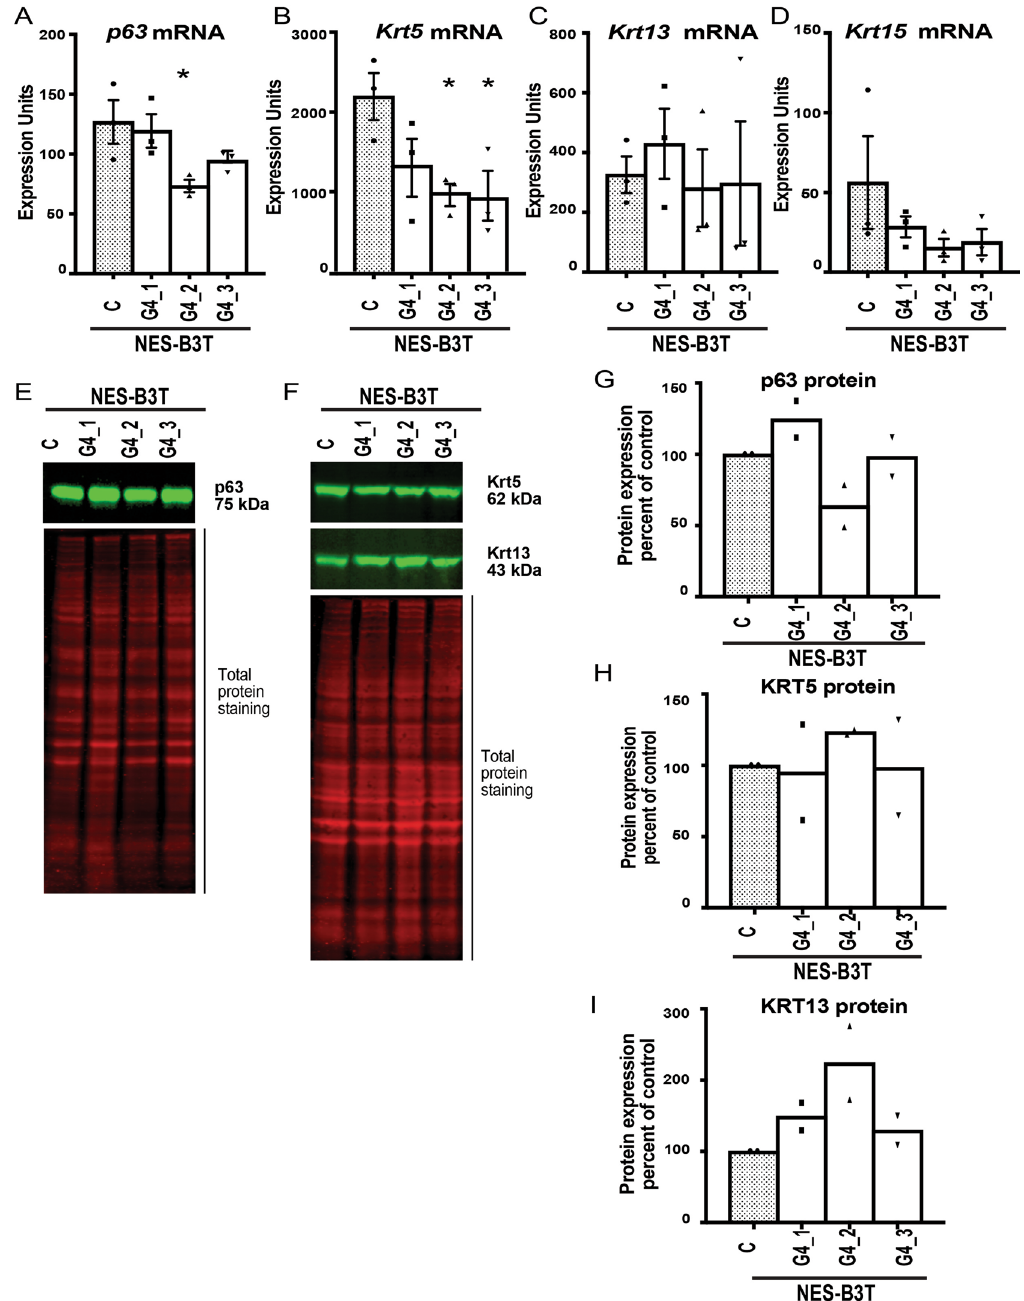
Figure 3. Effects of ectopic expression of GATA4 on the expression of squamous epithelial cell marker genes in human squamous esophageal epithelial NES-B3T cells were less pronounced than those observed in GATA4- expressing NES-B10T cells. Expression of four squamous epithelial cell marker genes (p63, KRT5, KRT13, KRT15 ) were examined by qRT-PCR and/or immunoblot in three pInducer20-GATA4 NES-B3T cell clones (G4_1, G4_2, G4_3) and one pInducer20 NES-B3T control cell clone (C) after 72 h of doxycycline treatment to induce GATA4. ( A – D ) qRT-PCR demonstrated a trend for reduction in the steady-state levels of p63 , KRT5 , and KRT15 , but not KRT13 , in NES-B3T cells expressing GATA4 compared with controls cells lacking GATA4 protein. Statistically significant reductions were observed for only one cell clone, G4_2, for p63 expression and two clones, G4_2 and G4_3, for KRT5 expression (n = 3 experiments; *P ≤ 0.05). ( E – I ) Quantitative infrared immunoblotting (LI-COR) was used to analyze p63, KRT5, and KRT13 protein expression in control and GATA4 expressing NES-B3T cell clones. Revert Total Protein Stain was used for normalization. Immunoblots were performed using extracts from two independent doxycycline induction experiments. Representative blots are shown in panels ( E ) and ( F ). Quantification of blots is shown in panels ( G – I ) with the abundance of protein detected in GATA-expressing clones expressed as the percent relative to the non-expressing control cells. Full immunoblots used to generate panels are shown in Supplementary Fig.